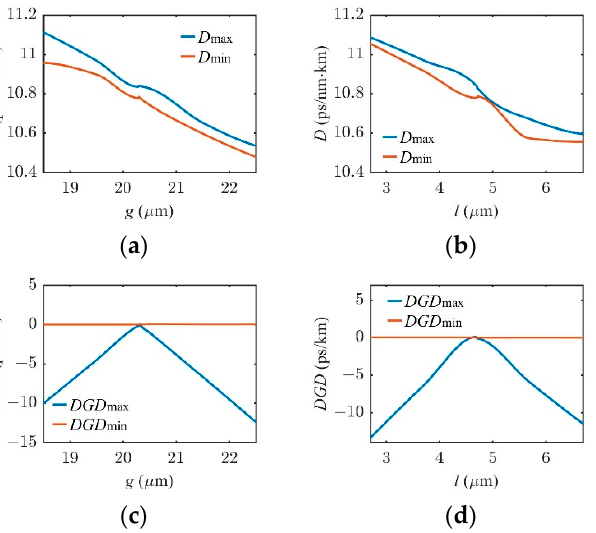
Figure 7. ( a ) Change in D with g ; ( b ) Change in D with l ; ( c ) Change in DGD with g ; ( d ) Change in DGD with l .